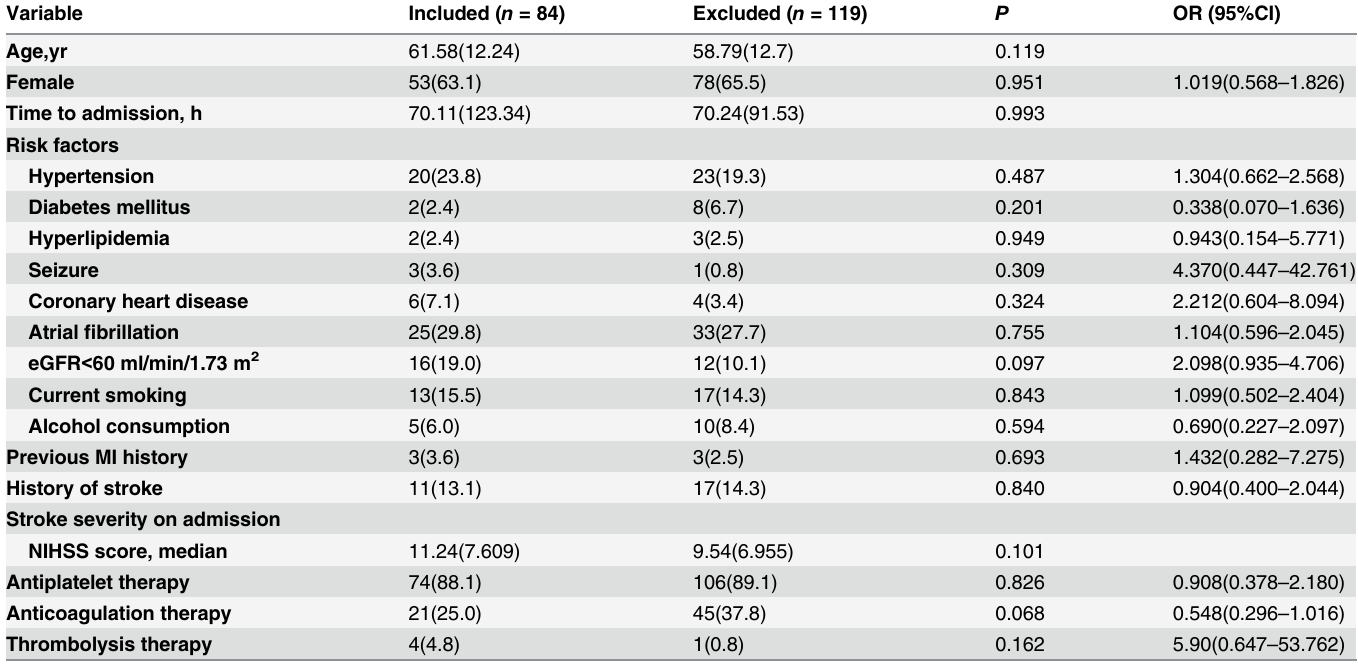
Table 1. Baseline characteristics of Chinese acute ischemic stroke patients with Rheumatic Heart Disease from the Chengdu Stroke Registry who were included or excluded from the present